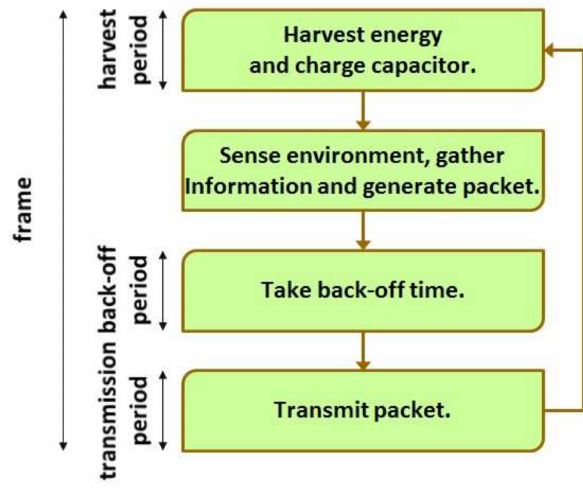
Figure 2. Time structure adopted by basic MAC scheme.